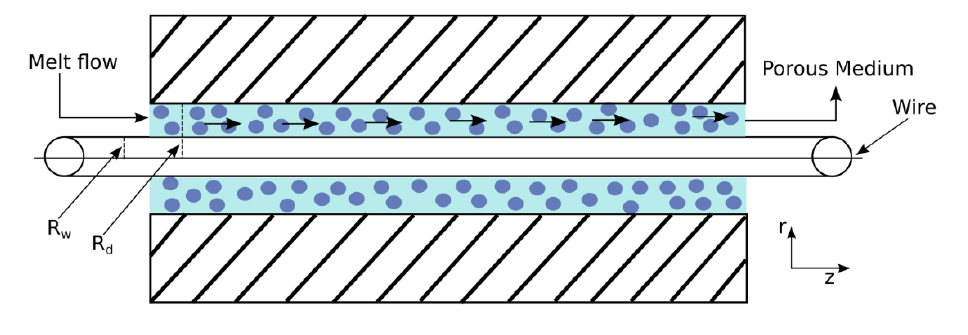
Figure 1. Geometry of the model problem.